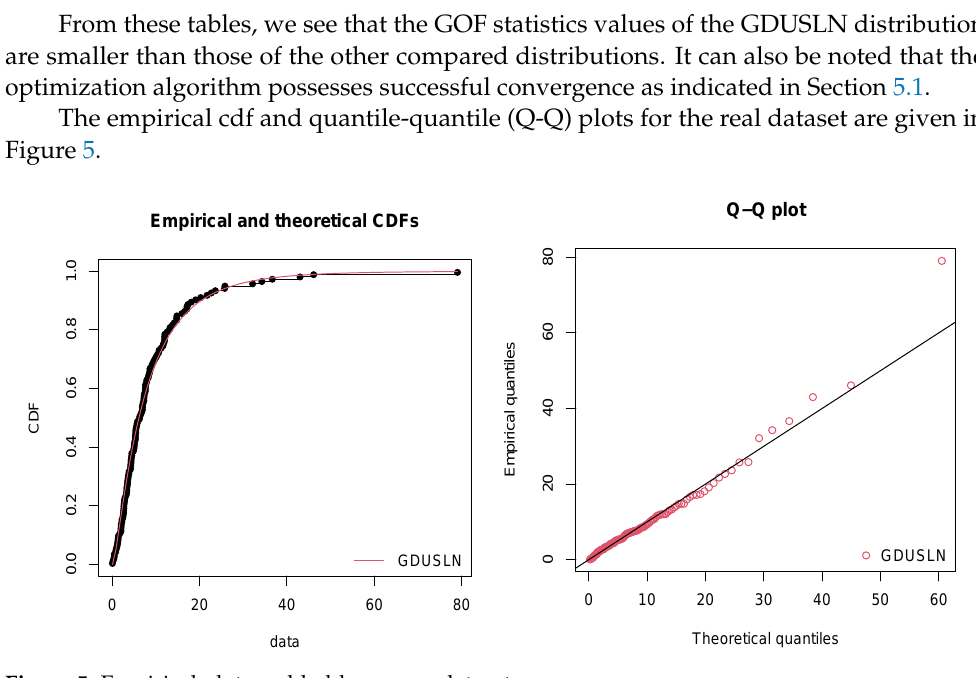
Figure 5. Empirical plots on bladder cancer